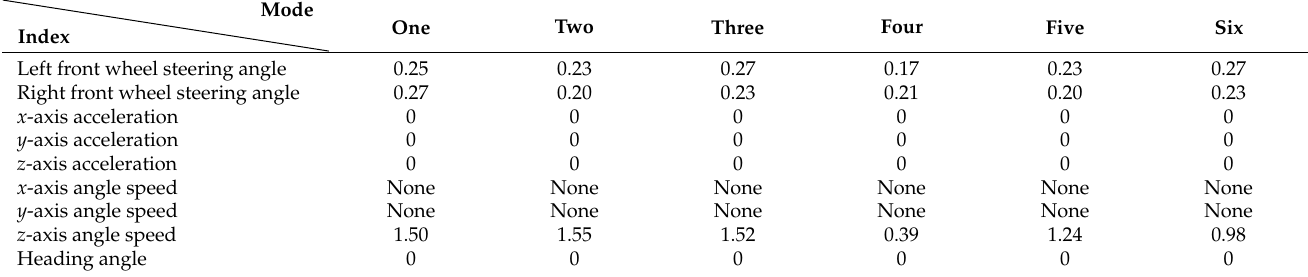
Table 2. Power spectrum frequencies for subsiding paddy field